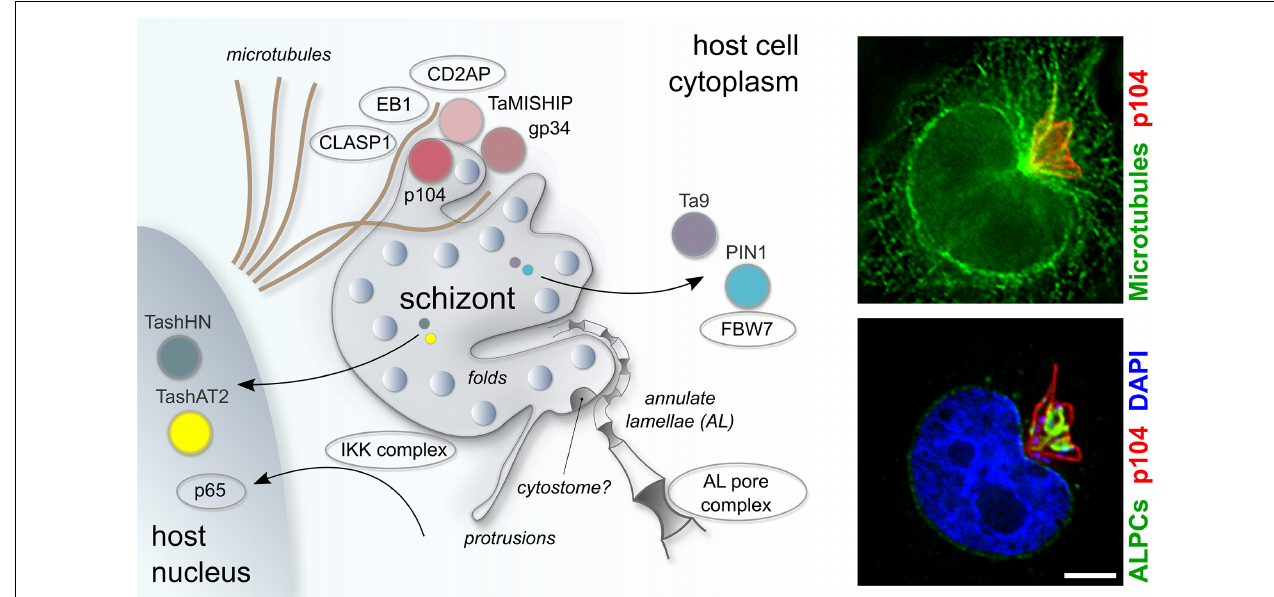
FIGURE 3 | Schematic representation of key host-parasite interactions in Theileria annulata infected leukocytes. Theileria schizonts export proteins into the host nucleus (TashAT, TashHN) or cytoplasm (PIN1, Ta9), where they have the potential to interact with host proteins (FBW7) to modify the host phenotype. Theileria interacts closely with host MTs, mediated in part by a protein complex on the schizont surface comprising bovine CLASP1, CD2AP, EB1 and the schizont proteins p104 and MISHIP. The IKK complex is recruited to the parasite surface, enabling the nuclear localization of NF-kB subunits (p65) to the host nucleus. Porous annulate lamellae that align closely to the schizont membrane are depicted, as are structural elements of the parasite plasma membrane such as dynamic protrusions and a potential cytostome. Fluorescent images show host MTs, labeled with anti-CLASP2 antibodies (green, top panel) and host ALPCs, labeled with anti-RanGAP1 (green, bottom panel) in relation to the schizont membrane, which is labeled with anti-p104 (red). The scale bar is 5 µ m.